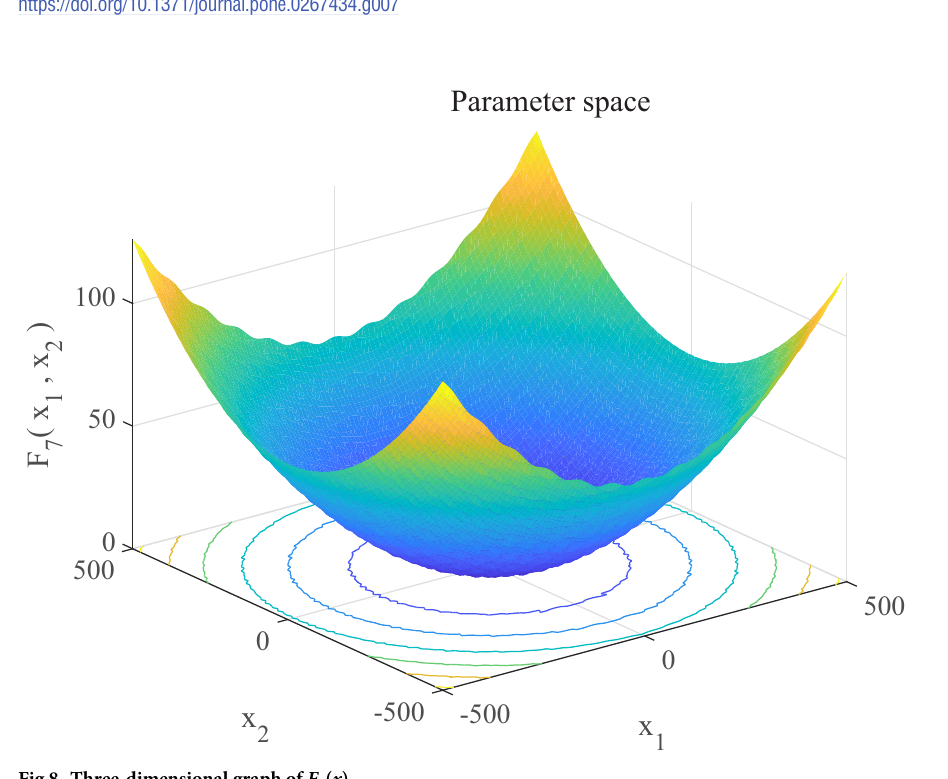
Fig 8. Three-dimensional graph of F 7 ( x